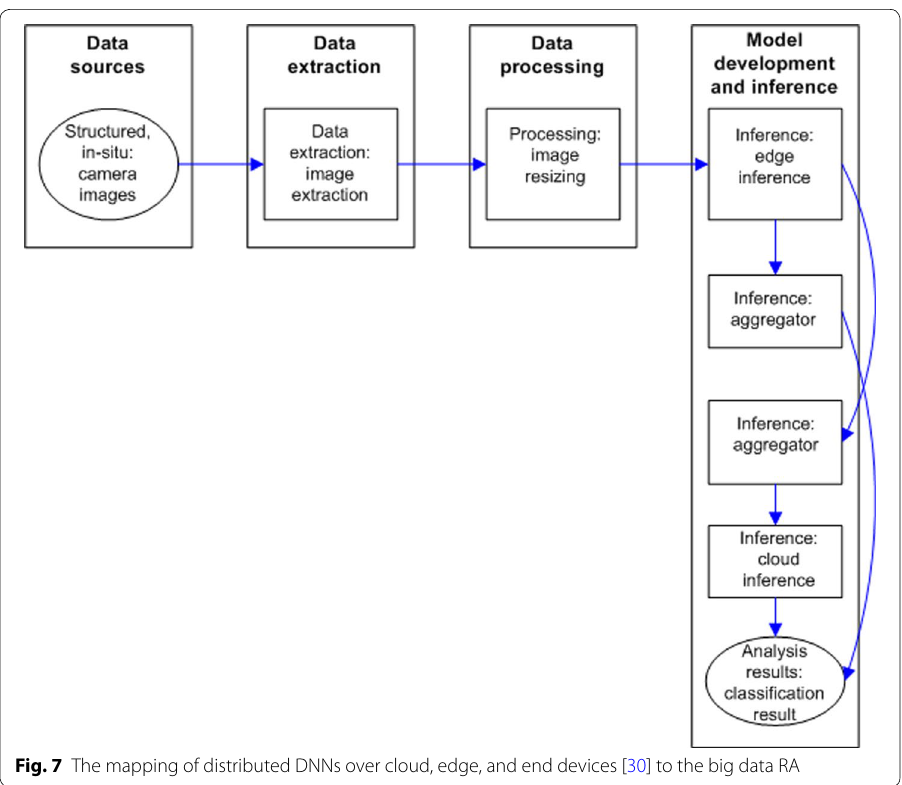
Fig. 7 The mapping of distributed DNNs over cloud, edge, and end devices [30] to the big data RA